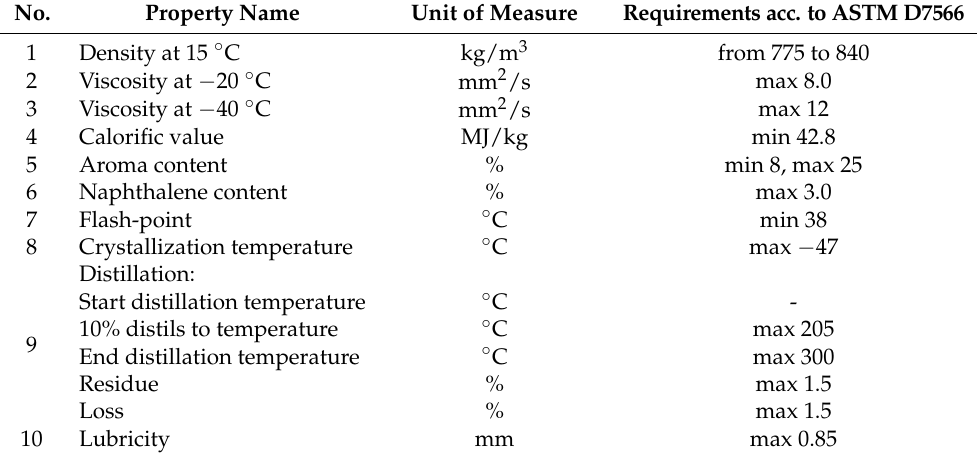
Table 1. Physicochemical properties according to ASTM D7566 standard.